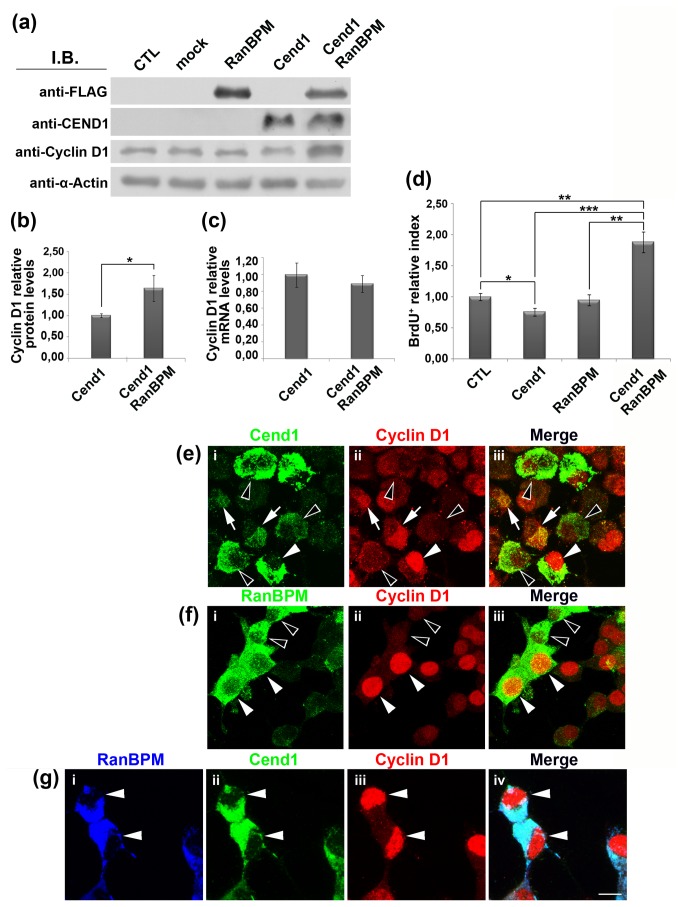
Cend1-RanBPM interaction enhances cyclin D1 levels and cell proliferation.(a) Western blot analysis of Neuro 2a cells transiently transfected with Cend1 or FLAG-RanBPM or both, using the indicated antibodies. An increase in cyclin D1 levels is noted upon Cend1-RanBPM co-transfection. Non-transfected Neuro 2a cells (CTL) and mock-transfected cells with empty vector were used as controls. (b) Quantification and normalization of cyclin D1 protein levels relatively to α-actin in Cend1 and Cend1/RanBPM transfected cells using the Image J software. (c) Quantification of cyclin D1 mRNA by real-time real-time RT-qPCR (d) Co-expression of RanBPM and Cend1 enhances BrdU incorporation. Estimation of the BrdU index was made by counting BrdU+ cells out of all cells in control cultures (CTL); BrdU+/Cend1+ cells out of all Cend1+ cells in Cend1-transfected cells; BrdU+/RanBPM+ out of all RanBPM+ cells in RanBPM-transfected cells; BrdU+/Cend1+/RanBPM+ cells out of all Cend1+/RanBPM+ cells in double transfected Neuro 2a cells, following a 1-hour BrdU pulse. At least 2000 cells were counted in each case and the BrdU index was calculated as the mean value from 6 independent experiments. Error bars represent SEM; ***Student’s t-test, p<0.001. (e- g) Co-expression of Cend1 and RanBPM stabilizes cyclin D1 in the nucleus. In Neuro 2a cells transiently transfected with Cend1, cyclin D1 is either extinct (open arrowheads) or exported from the nucleus to the cytoplasm (white arrows), and only occasionally maintained in the nucleus (white arrowhead) of Cend1+ cells (e). In RanBPM-transfected cultures, cyclin D1 is found in the nucleus (white arrowheads) or is extinct (open arrowheads) in RanBPM+ cells similar to control untransfected cells (f). In contrast, in all Cend1+/RanBPM+ cells cyclin D1 exhibited entirely nuclear localization (arrowheads in g). Scale bar: 10 μm.